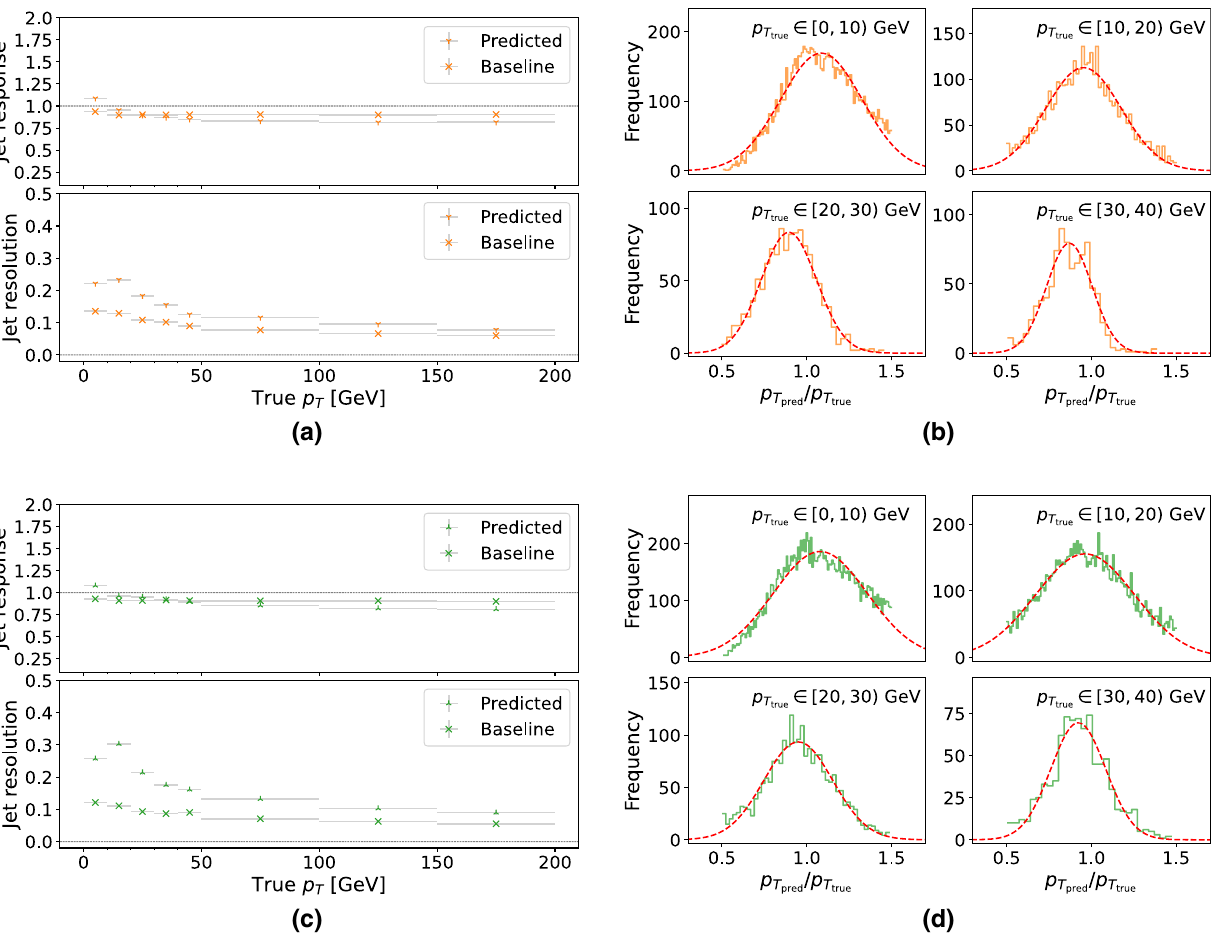
Fig. 13 Jet reconstruction performance. a Mean jet response (top) and resolution (bottom) in 40 pileup as functions of the true p T . b Response distributions and the fitted Gaussian functions in different p T ranges corresponding to ( a ). c Mean jet response (top) and resolution (bottom) in 200 pileup as functions of the true p T . d Response distributions and the fitted Gaussian functions in different p T ranges corresponding to